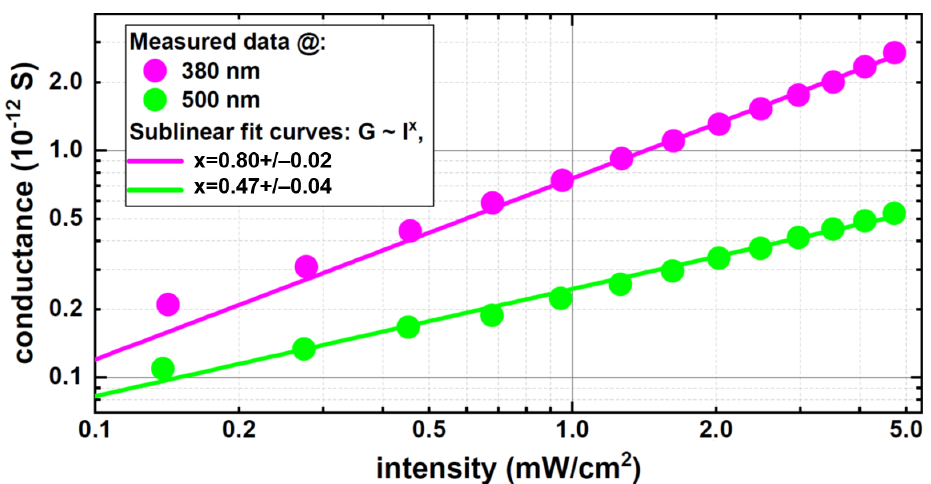
Figure 8. Double-logarithmic conductance-vs.-intensity plots of the z-cut SBN61 crystal at 500 nm and 380 nm excitation wavelengths with dots symbolizing the measured values, averaged as described in Section 2, and straight lines showing the corresponding sublinear fit